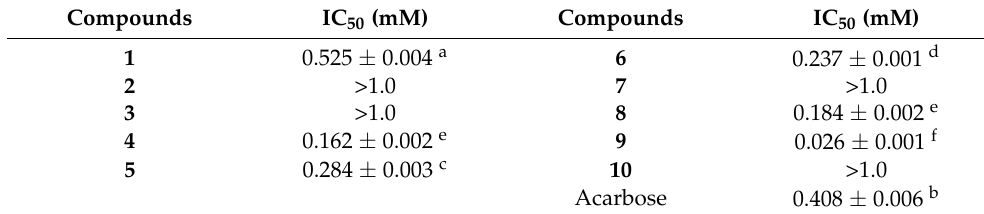
Table 4. α -Glucosidase inhibitory activity of compounds 1 – 10